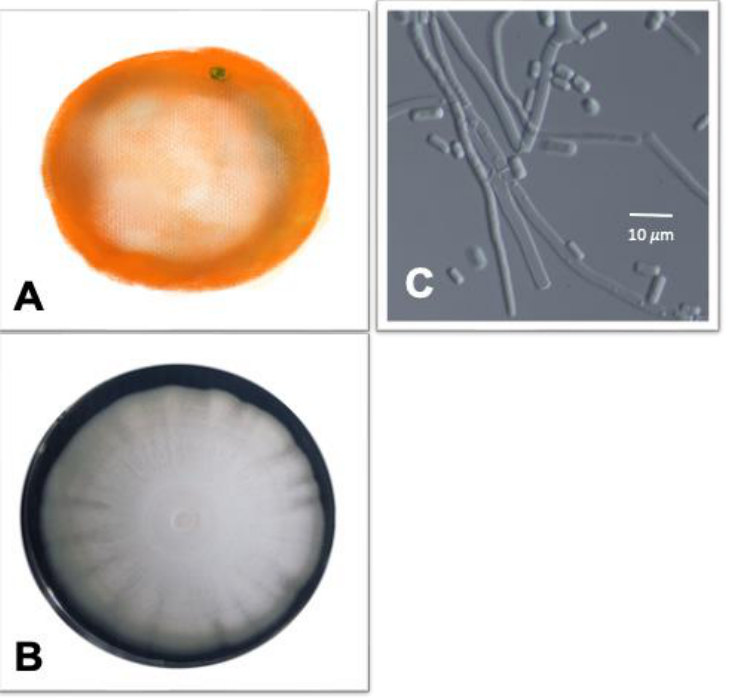
Figure 5. Sour rot caused by Geotrichum citri-aurantii , ( A ) = the symptom on fruit; ( B ) = colony and ( C ) = conidia morphology .